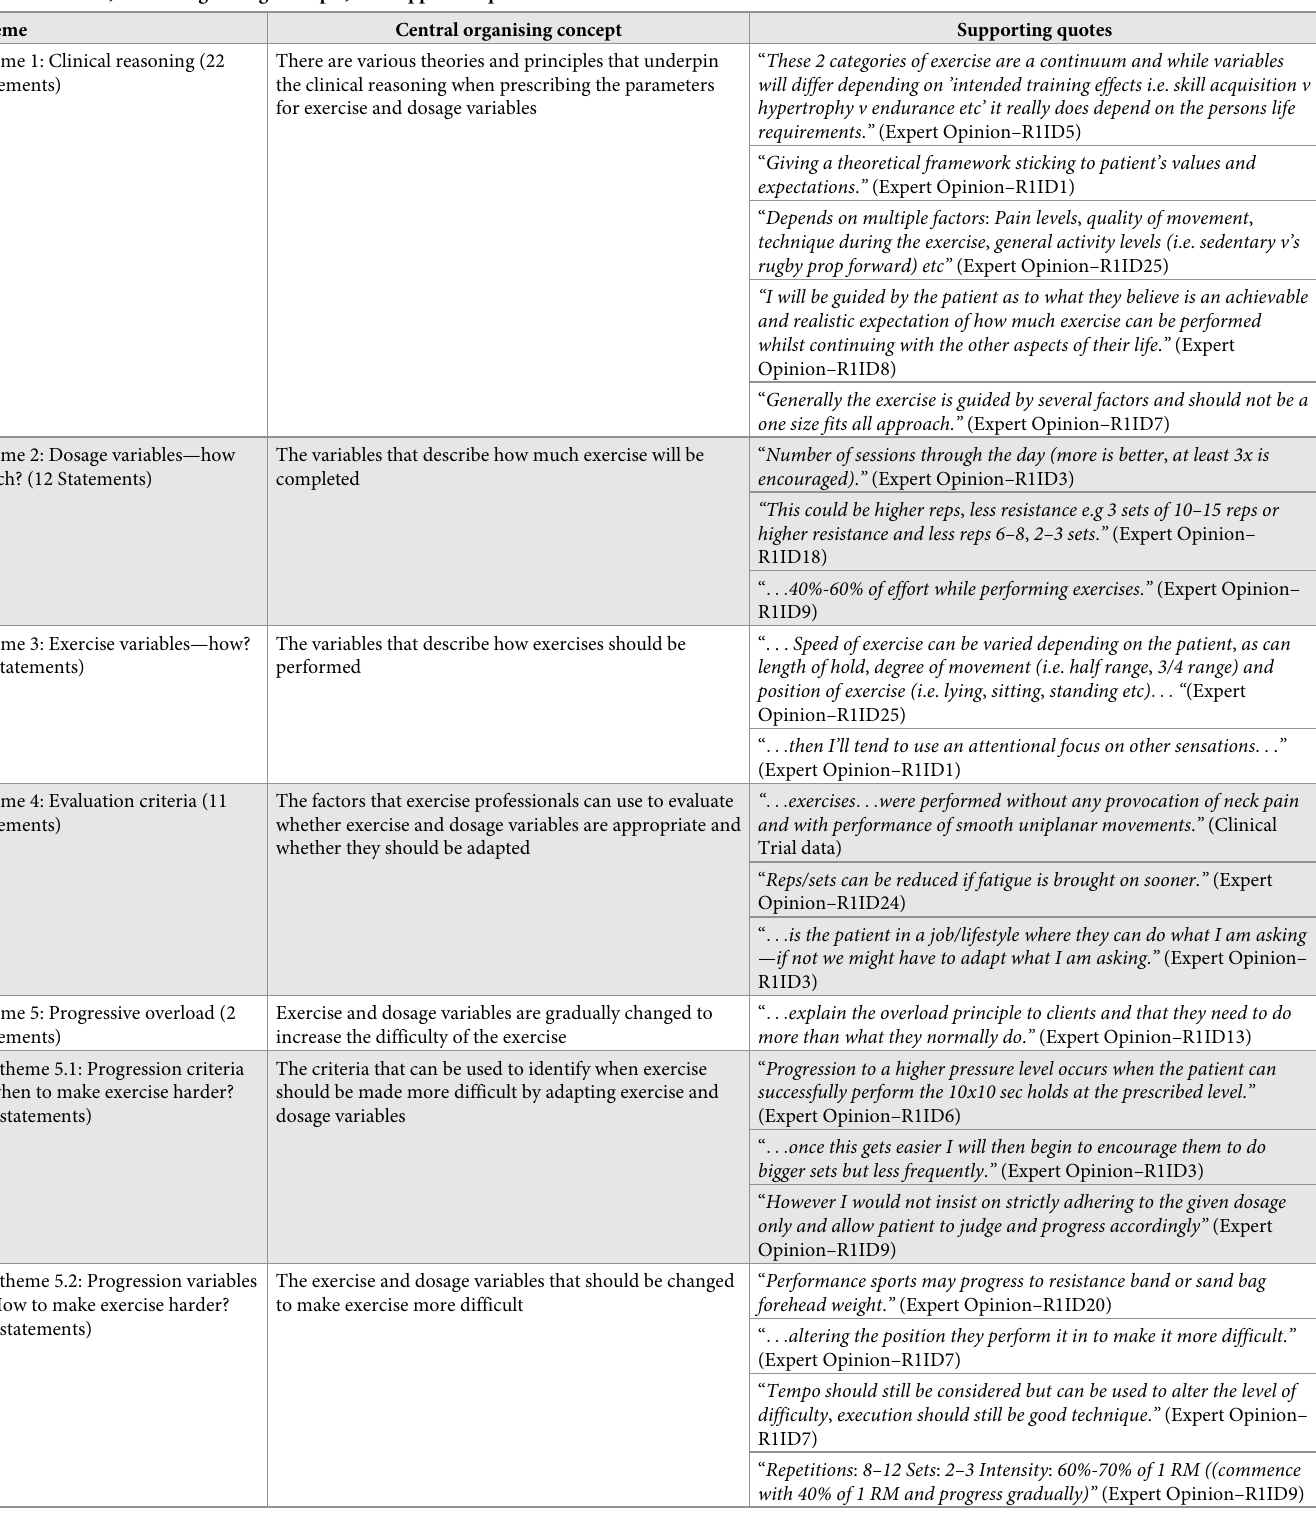
Table 2. Themes, central organising concepts, and supportive